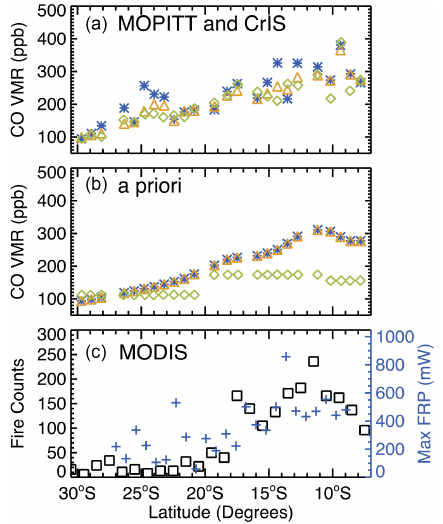
Figure 3. Averaged CO volume mixing ratio (parts per billion) from the surface to 3km ( ∼ 700hPa), fire counts, and maximum fire ra- diative power (milliwatts) measured by Aqua MODIS over Africa for 28 August 2013. (a) MOPITT joint TIR–NIR CO data products (blue stars), MOPITT TIR CO data products (green triangles), and CrIS TIR CO VMR using a priori profiles identical to those used in the Aura TES operational retrievals (golden diamonds); (b) a pri- ori CO VMR used in MOPITT (green/blue) and CrIS (gold) re- trievals; (c) fire counts (black squares) and maximum fire radiative power (blue plus) among the Aqua MODIS measurements whose data quality confidences are greater than